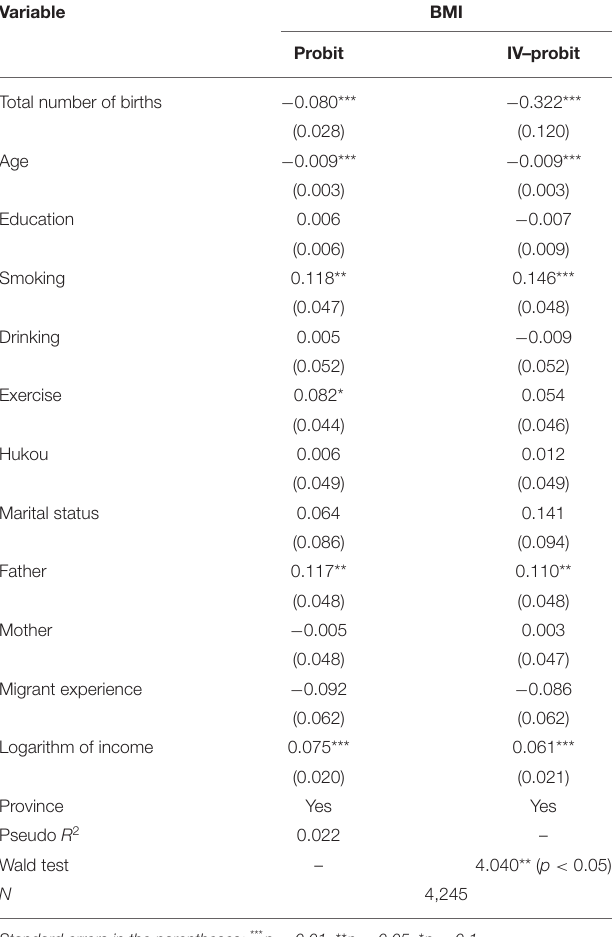
TABLE 8 | Robustness check of alternative explained variable